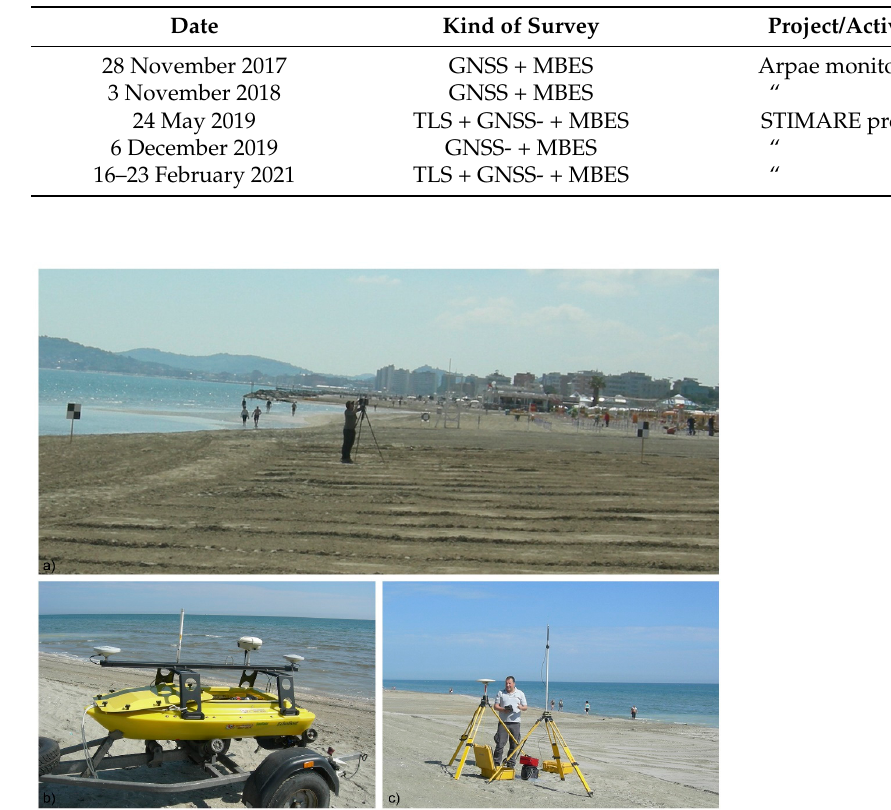
Commented [M7]: Updated to a shaper one. Figure 5. ( a ) TSL survey; ( b ) ASV used for multibeam bathymetric surveys; ( c ) GNSS-NRTK system